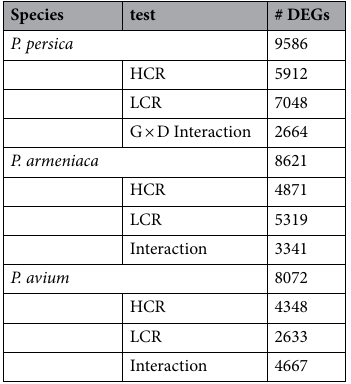
Table 1. Number of differentially expressed genes (DEGs) identified in each LRT test for each species, together with the number of non-redundant DEGs in each